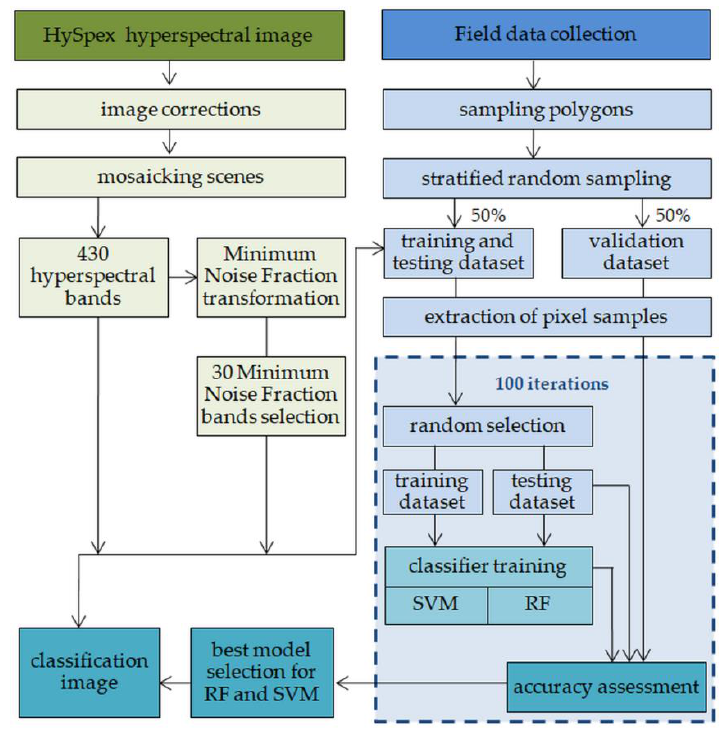
Figure 3. Research algorithm.